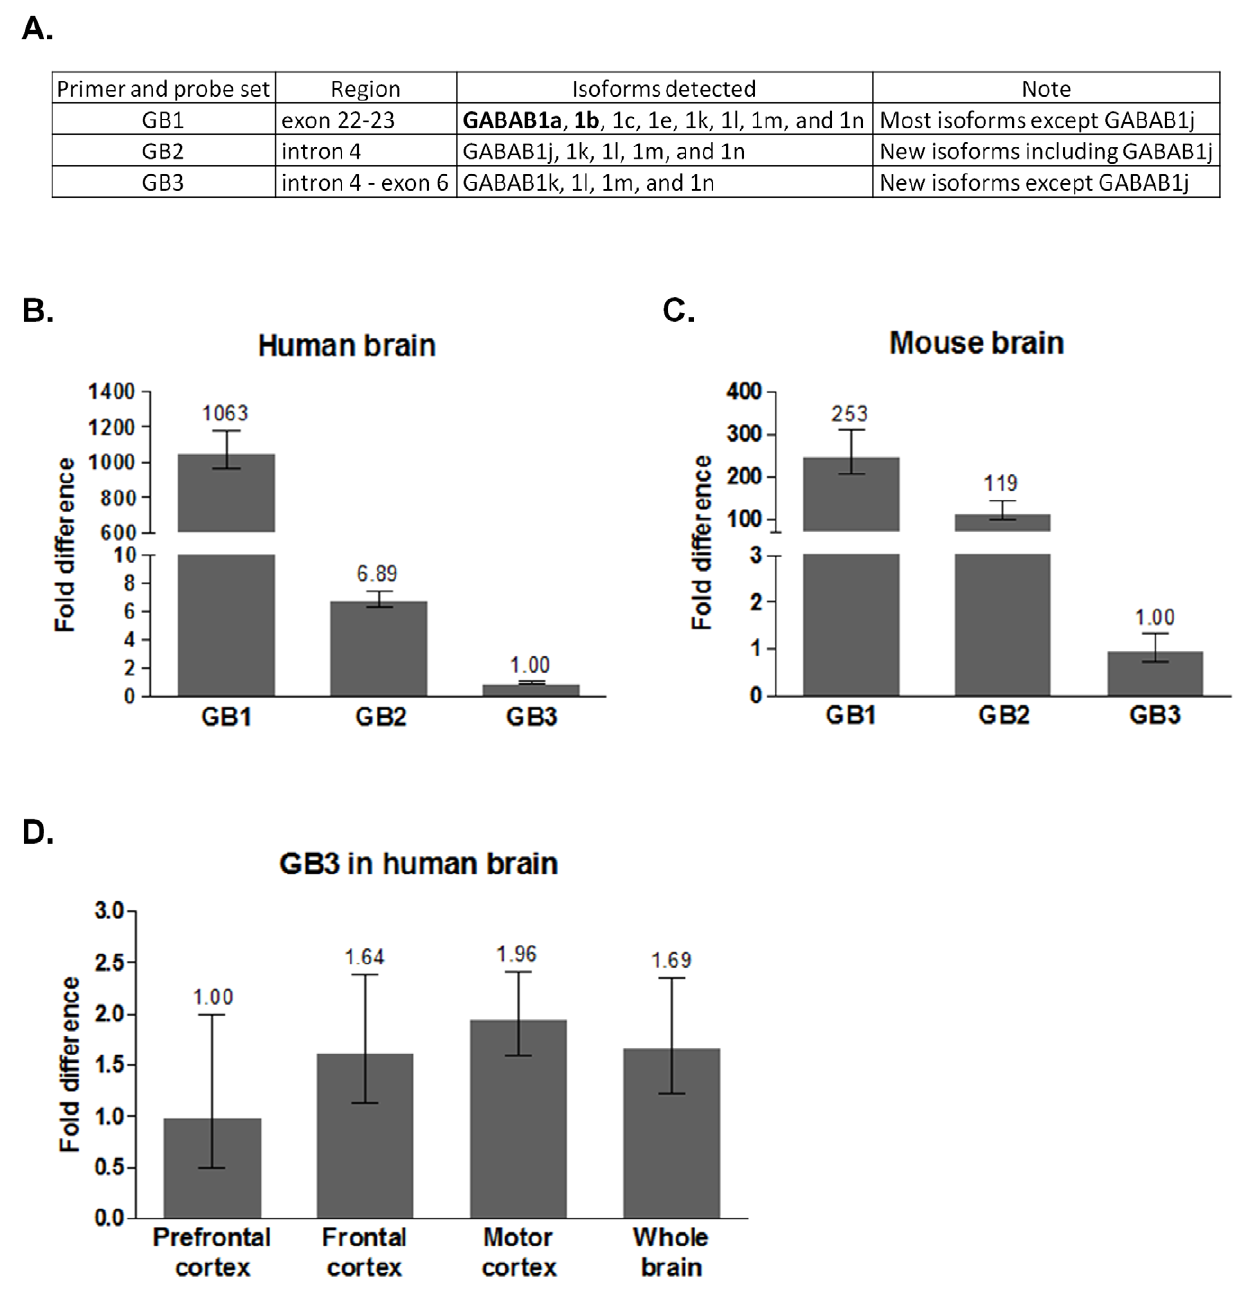
Figure 4. The expression of GABAB1 isoforms. A. For quantitative real-time PCR, primer and probe sets were designed from human and mouse. GB1 sets were designed by the last two exons, exon 22 and 23, and were used for detecting most known GABAB1 isoforms except GABAB1j. They also represented the microarray probes that aligned to 5 9 exons of GABAB1 gene. GB2 sets were for detection of GABAB1j, k, l, m, and n. They aligned to intron 4 and designed for human cDNA microarray probe, clone 300899, and its mouse homologous probes. GB3 sets targeted intron 4 through exon 6 and were specific for GABAB1k, l, m, and n. B. In human brain, GB1 showed much more dominant expression than GB2 and GB3. C. GB1 expression was also stronger than GB2 and GB3 in mouse brain. However, GB2 and GB3 expression levels in mouse brain were much higher than human brain if they were compared with GB1 expressions. D. In human, GB3 expressions were similar in prefrontal cortex, frontal cortex, and motor cortex.